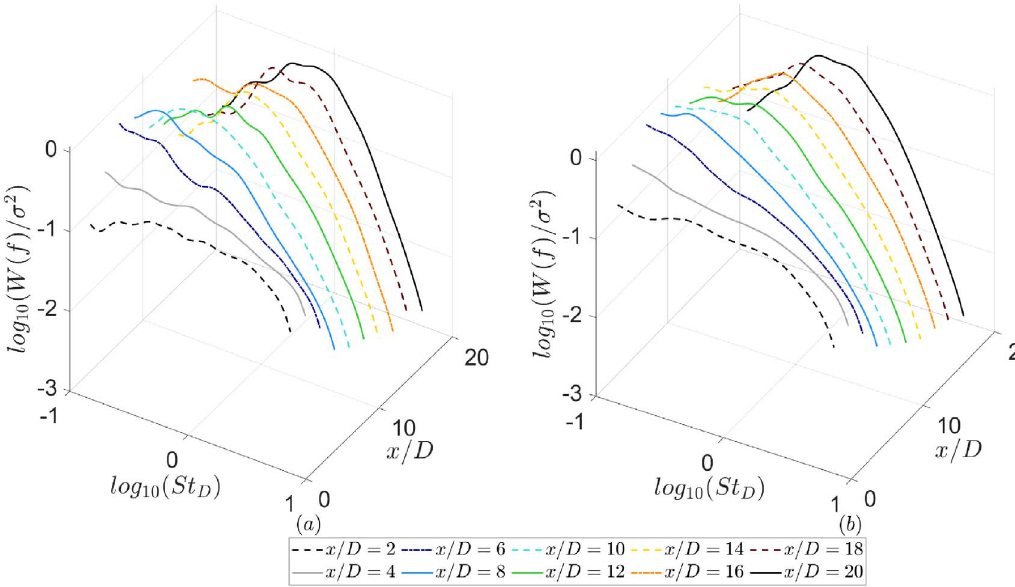
Figure 6. Wavelet spectra taken at r / D = 3 for different x / D and different TI: (a) TI = 3% and (b) TI = 9%.